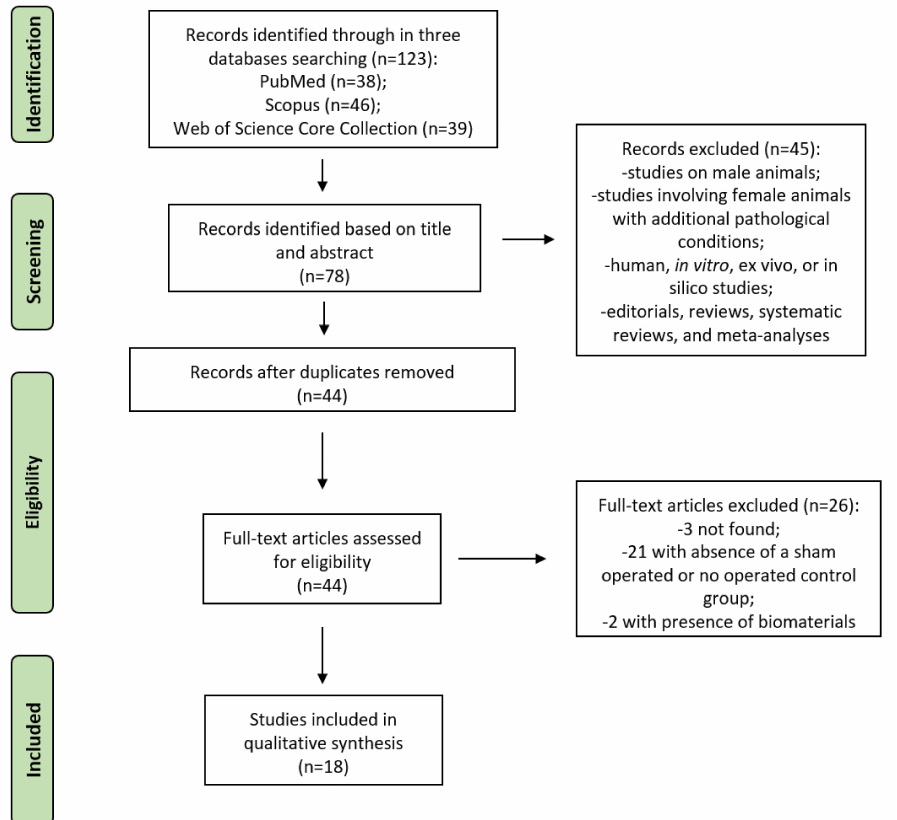
Figure 3. Systematic review flow diagram. The PRISMA flow diagram for the systematic review detailing the database searches, the number of abstracts screened, and the full texts